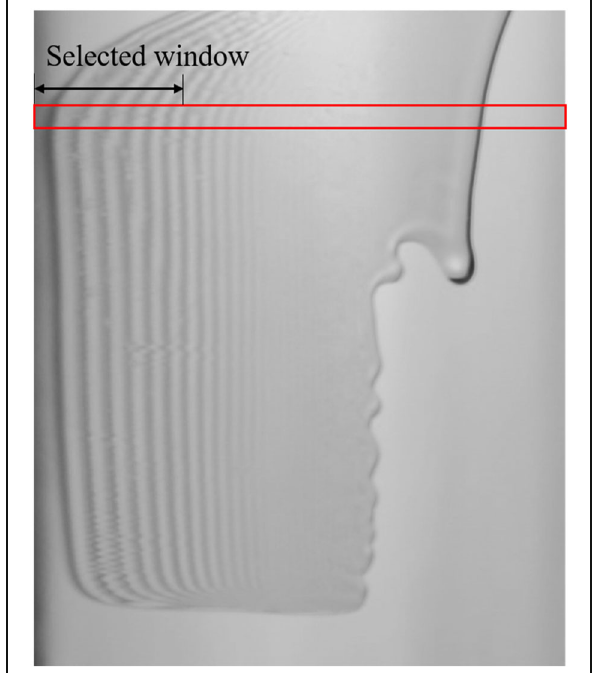
Fig. 3 Imported oil film fringe image from the experiment in grayscale. The red frame indicates the position of data used for illustration in Fig.